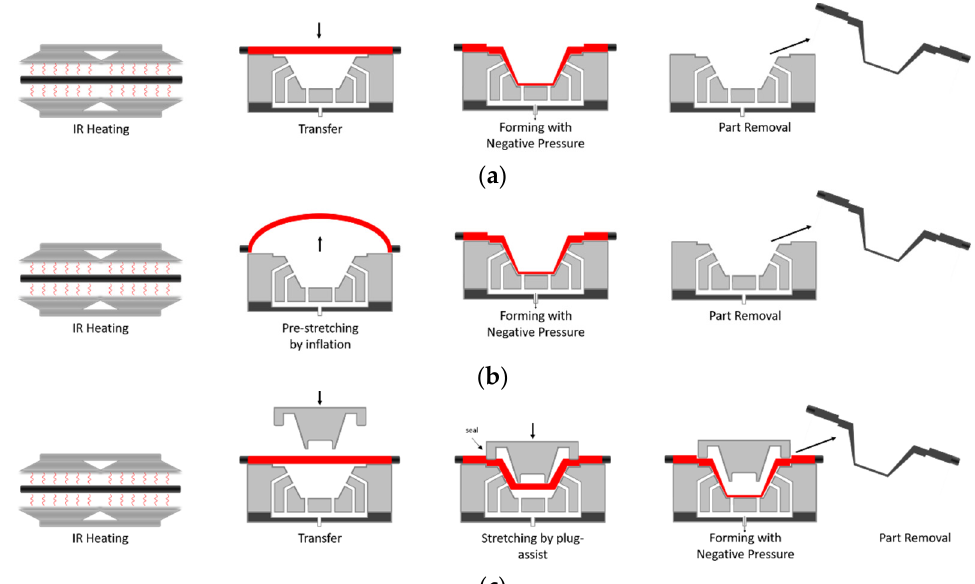
Figure 2. ( a ) Basic vacuum thermoforming process, ( b ) vacuum thermoforming with pre-stretching via inflation of a bubble, ( c ) vacuum thermoforming using a plug-assist.